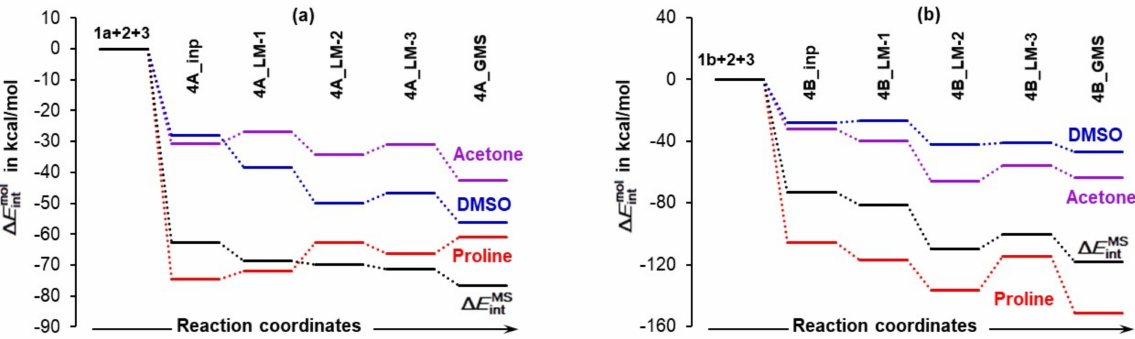
Figure 8. Relative to interaction energies computed for separate molecules, changes, ∆ E mol , in int the sum of intra- and intermolecular interaction energies computed for the indicated individual molecules constituting a molecular system (either 1a + 2 + 3 ( 4A ) in part ( a ) or 1b + 2 + 3 ( 4B ) in part ( b )) undergoing a structural change. Inp, LM, and GMS stands for input, local minimum, and global minimum structures of 3-MCs. A trend in ∆ E MS (it accounts for all interactions in a molecular system) int is also